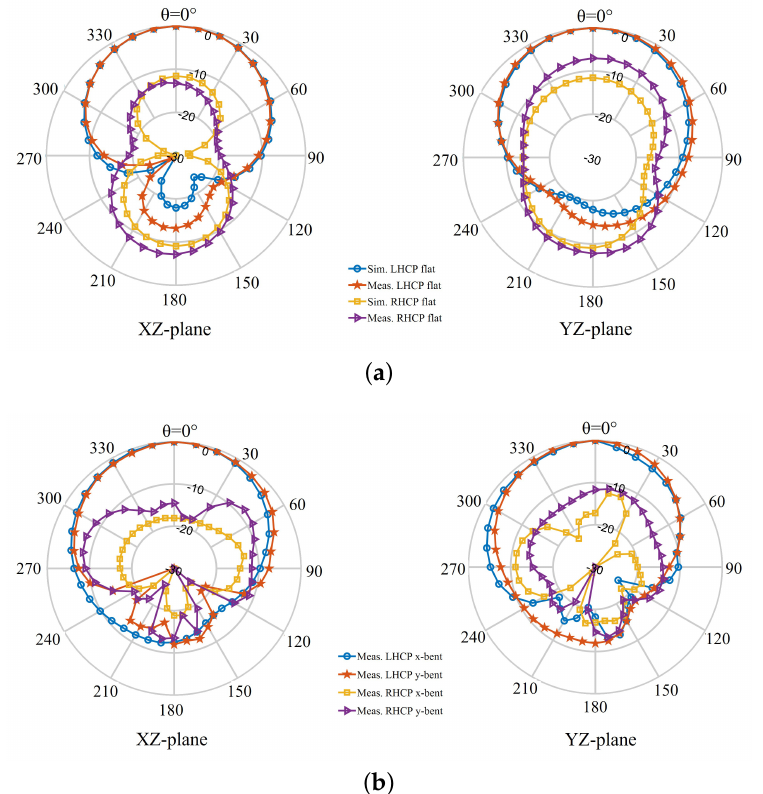
Figure 28. Simulated and measured far-field radiation patterns of the non-transparent antenna at 2.4 GHz: ( a ) unbent state, ( b ) bent